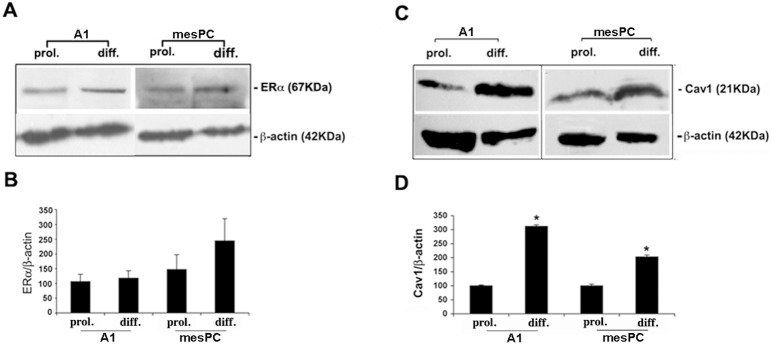
In A1 cells and in mesPC, differentiation increases Cav1 protein expression but not ERα.Lysates from A1 and from mesPC proliferating/undifferentiated and non-proliferating/differentiated were immunoblotted using ERα (A), Cav1 (B) and ß-actin (A, C) antibodies. ERα, Cav1 and ß-actin specific bands were detected at 67 kDa, 21 kDa and 42 kDa in both proliferating (prol.) and non-proliferating (diff.) cells. (B, D) The diagrams show the relative quantitation of the ERα and Cav1 in proliferating and non-proliferating A1 and in mesPC cell line respectively. Data are expressed as ratios of ERα/ß-actin and Cav1/ß–actin. The blots are representative of three separate experiments. Asterisks represent p<0.01 when compared to proliferating cultures (ANOVA, Scheffè F-test).